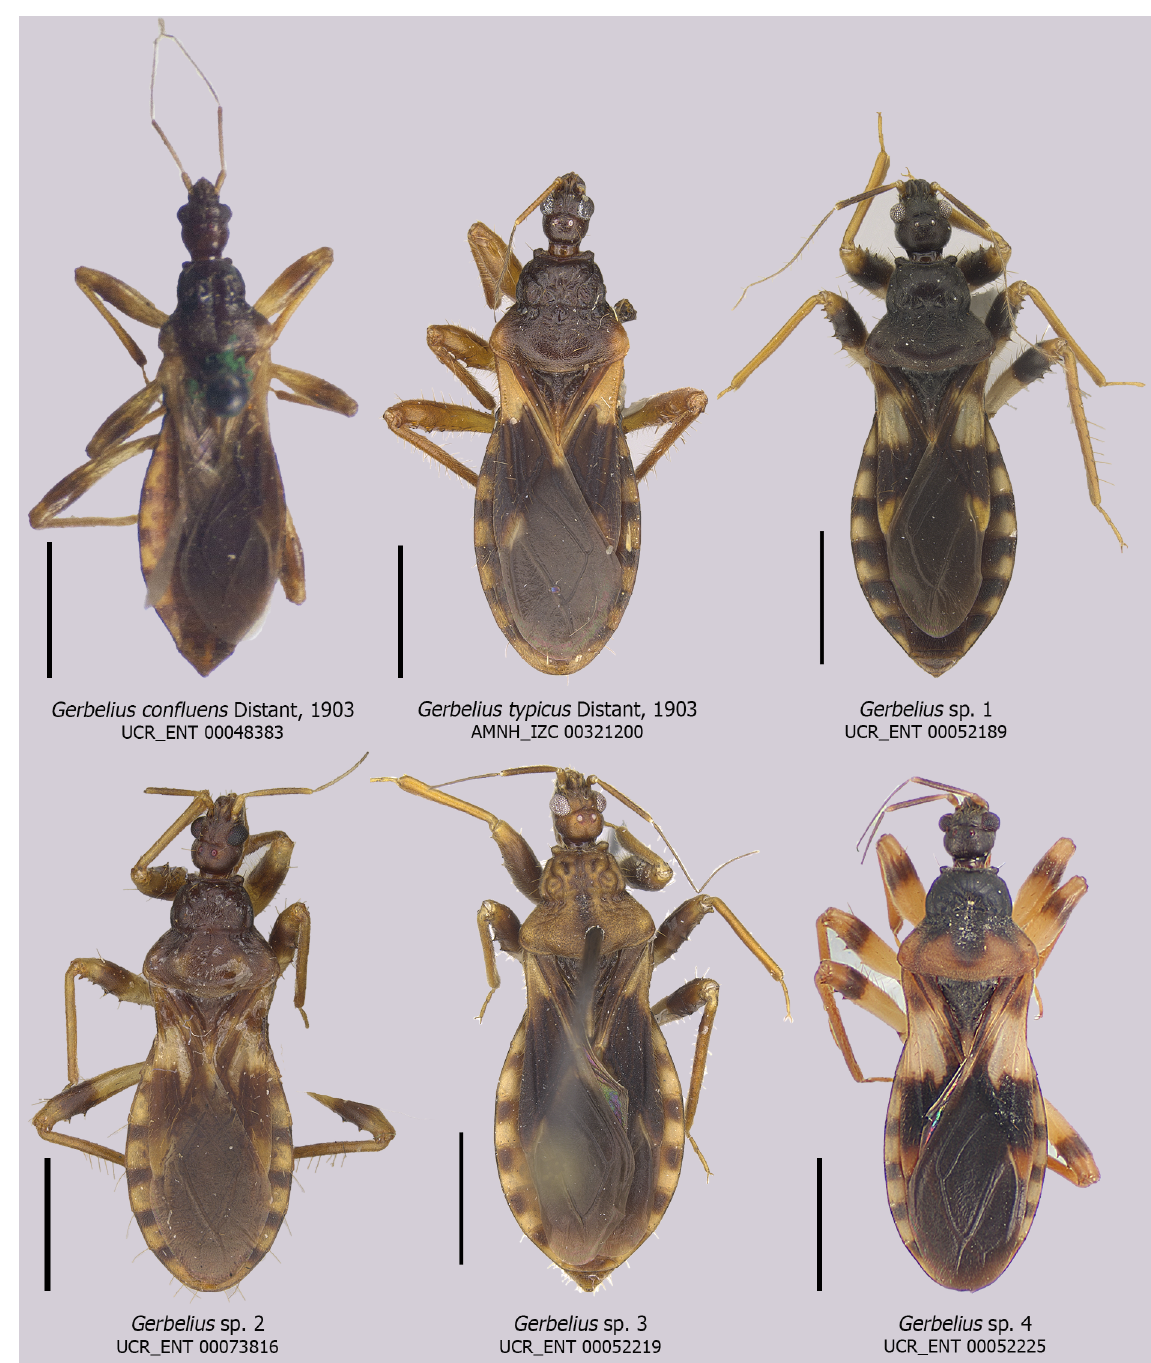
Fig. 5. Dorsal habitus of species of Gerbelius Distant, 1903. Scale bars = 2